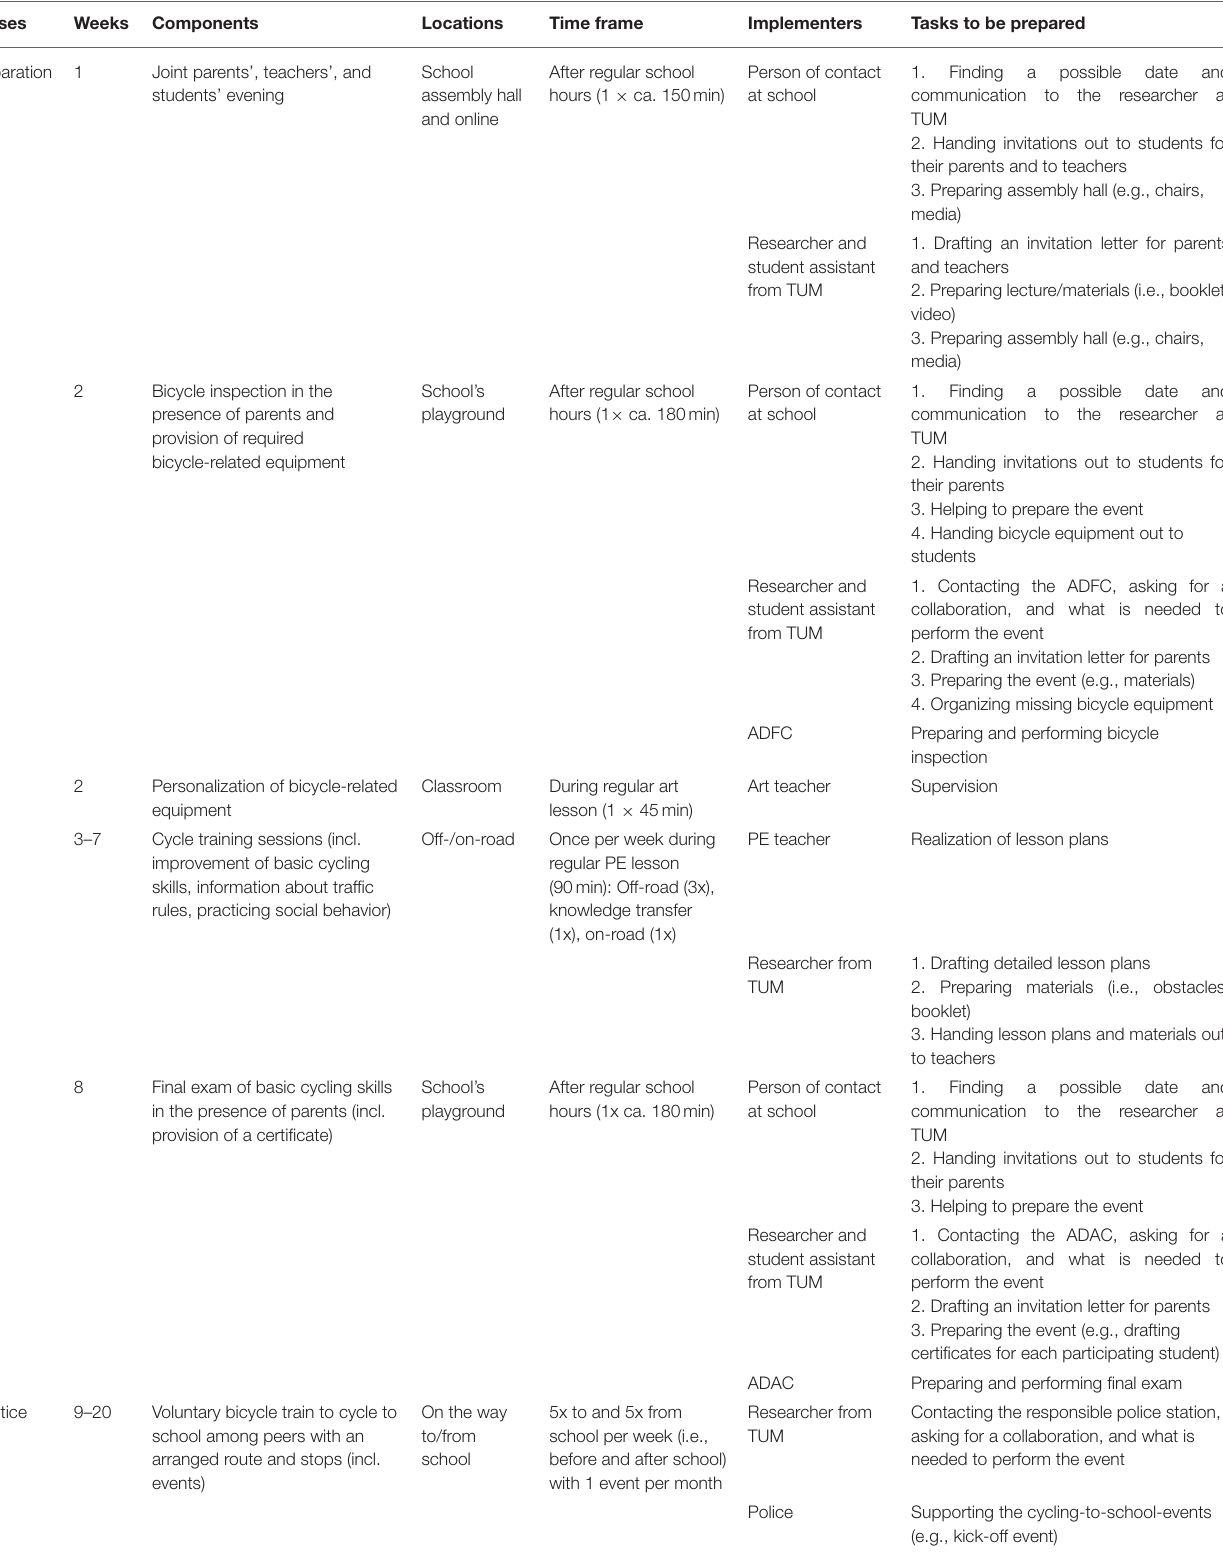
TABLE 3 | Program implementation plan.